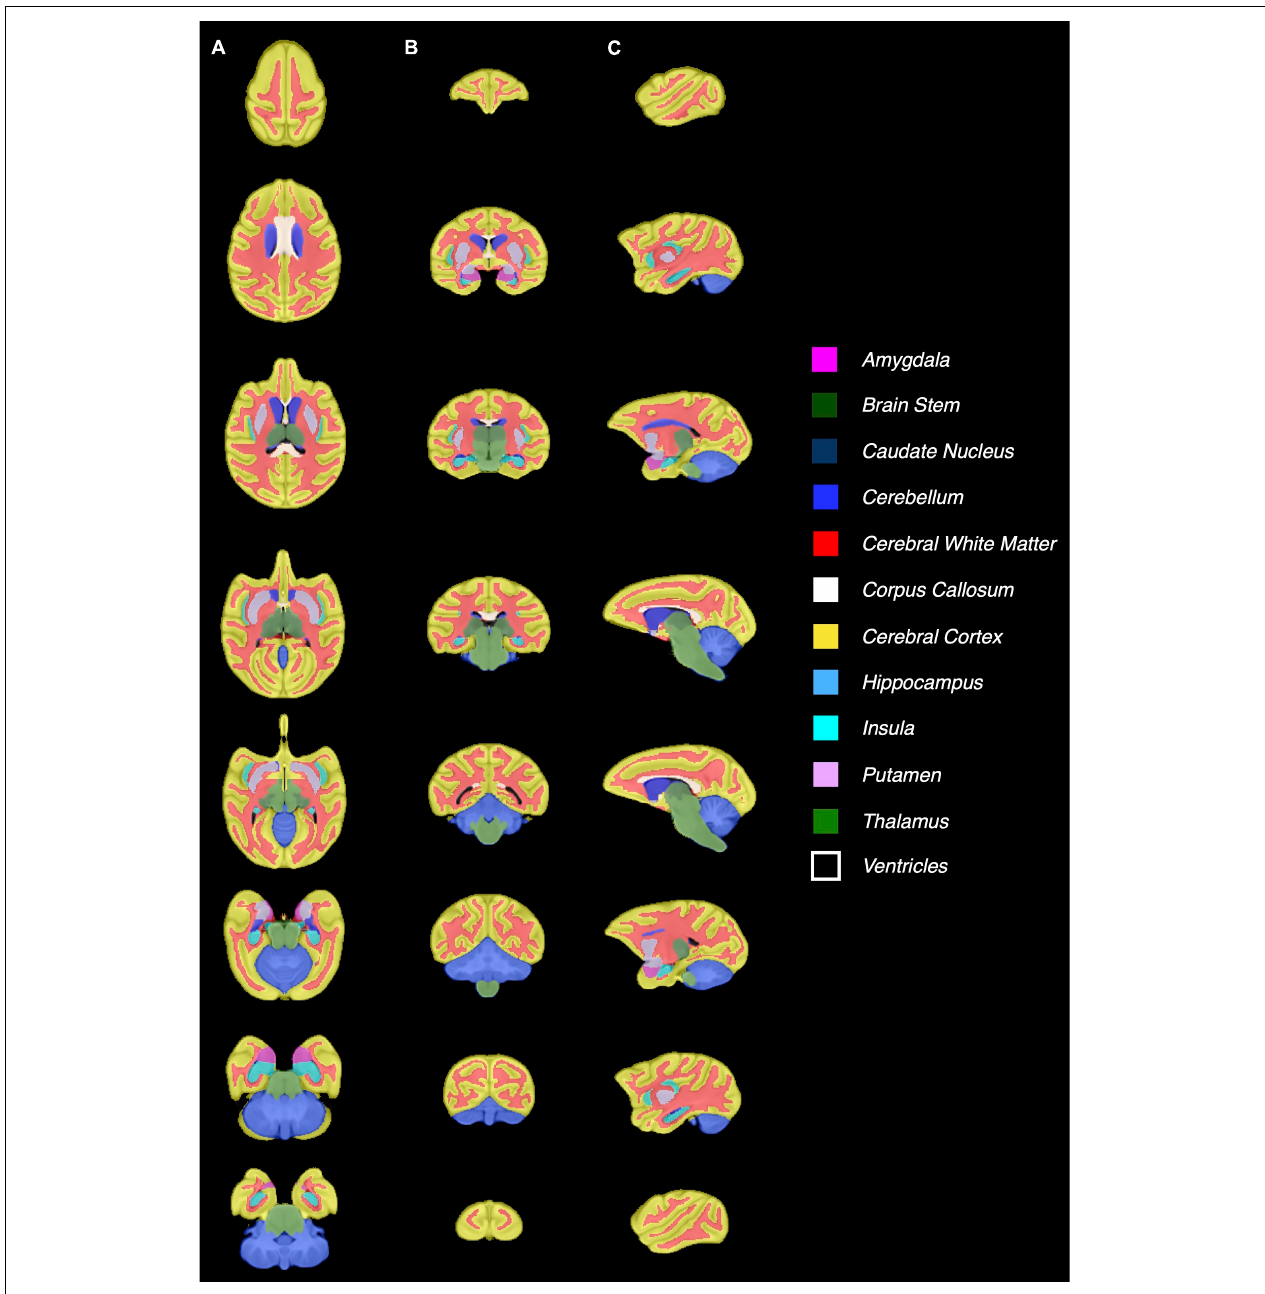
FIGURE 3 | Demonstration of the baboon ( Papio anubis ) brain atlas. Nine different slices are presented for (A) axial, (B) coronal, (C) sagittal